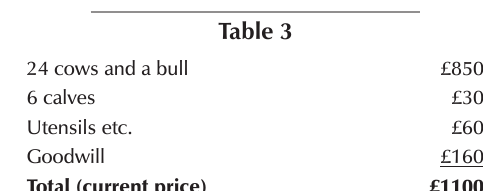
enterprise, as indicated in Table 3.